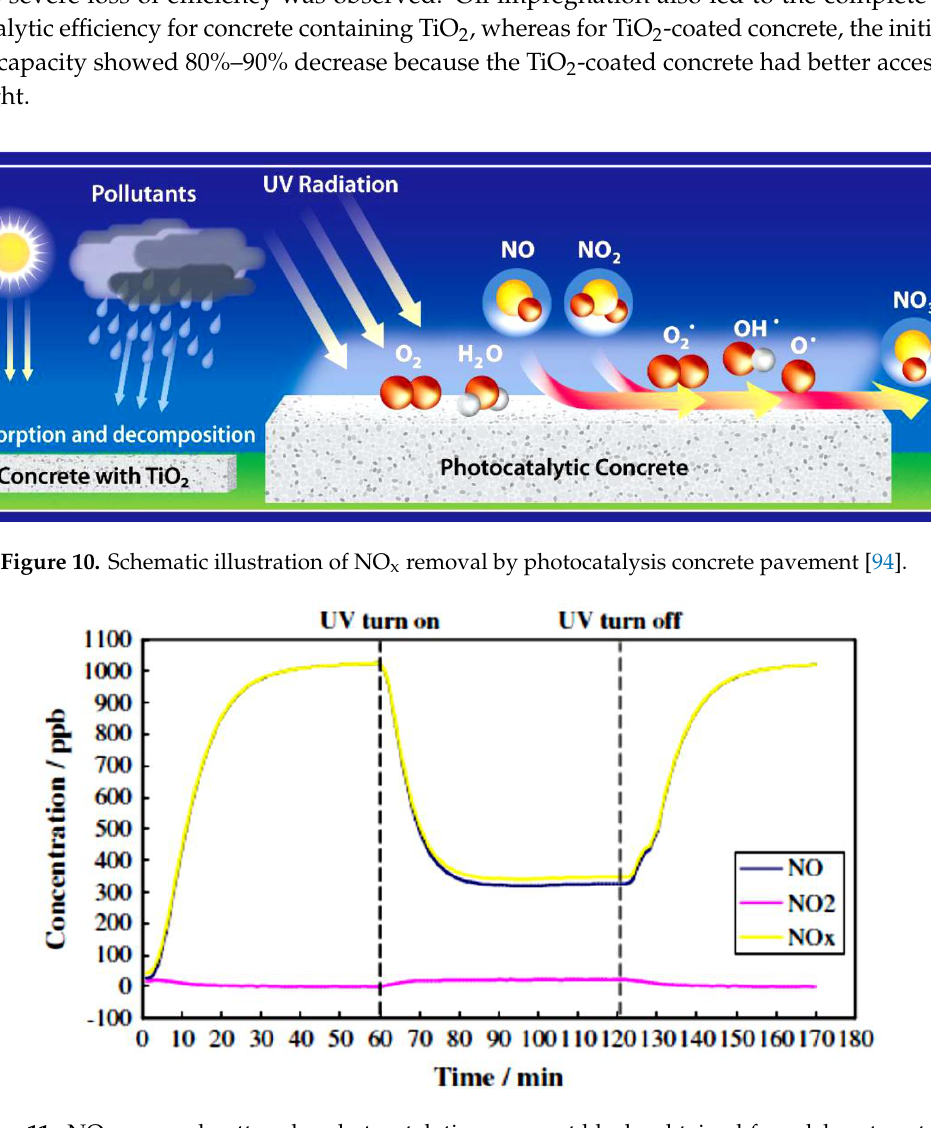
Figure 11. NO x removal pattern by photocatalytic pavement blocks obtained from laboratory test methods [4].